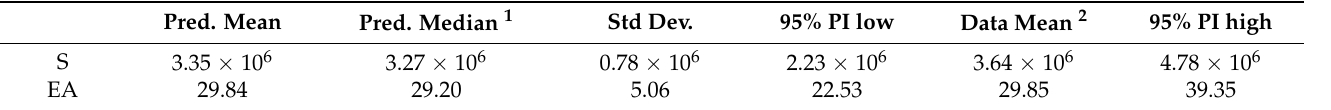
Table 4. Results of the three confirmatory experiments to validate the models of the desirability function and the quadratic models for the transformed responses of number of spores and AE per